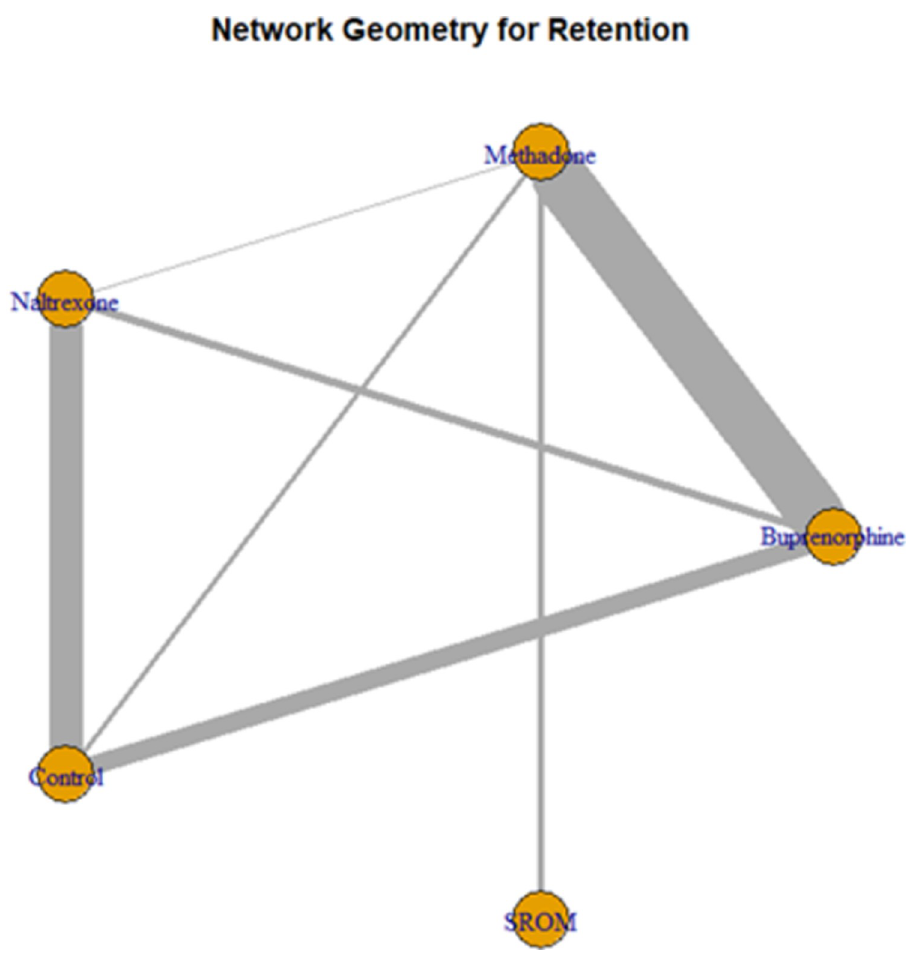
Fig 2. Network geometry for the treatment retention outcome for each medication or control